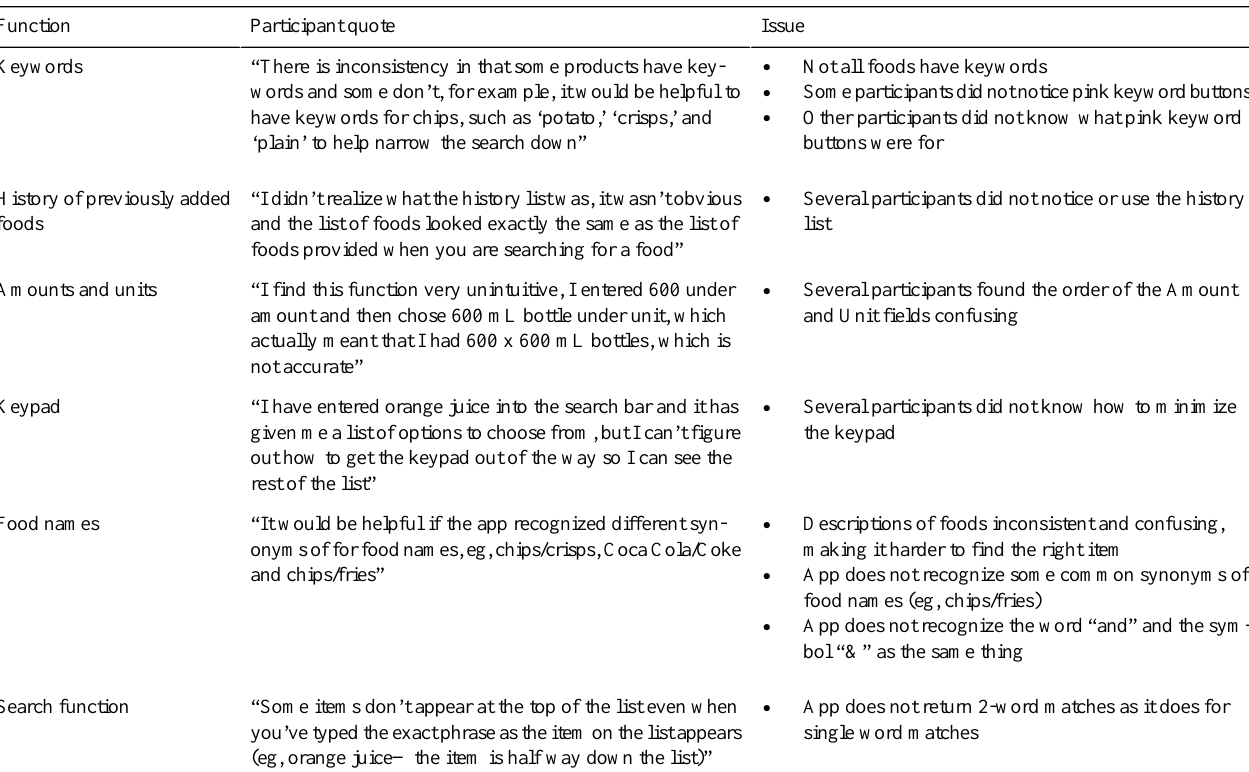
Table 2. Issues and improvements identified in Phase 3 of usability